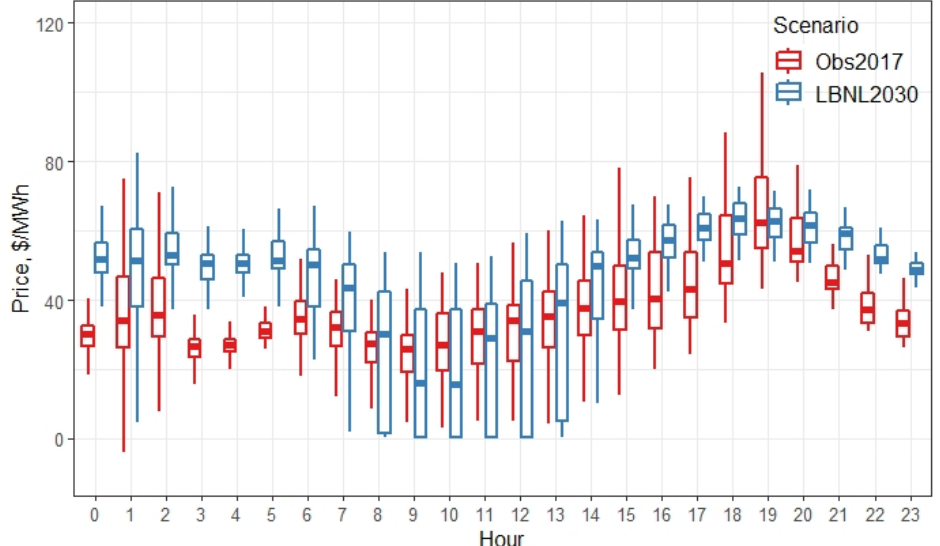
Figure 6. Hourly electricity price of the two price scenarios. Hourly mean values are represented by the horizontal line and interquartile ranges are represented by the boxes and vertical lines.